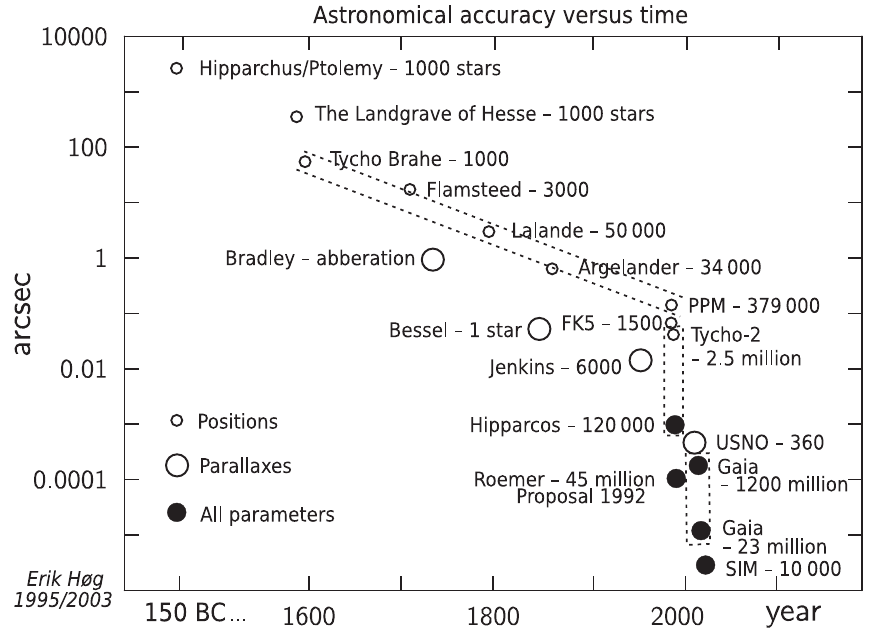
Fig. 4. Astrometric accuracy during the past 2000 years. The accuracy was greatly improved shortly before 1600 by Tycho Brahe. The following 400 years brought even larger but much more gradual improvement before space techniques with the Hipparcos satellite started a new era of astrometry. Source: Høg